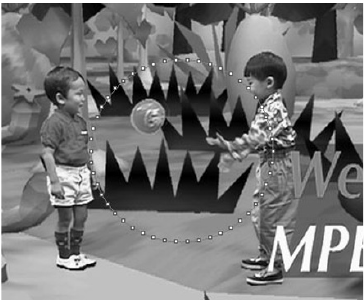
Figure 2: Interpolating spline initialization.